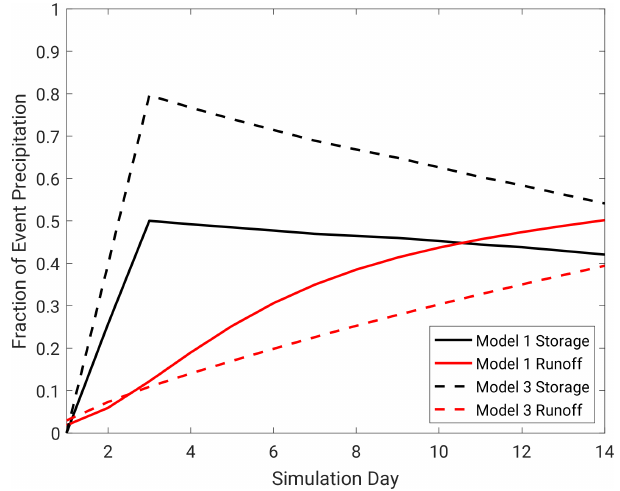
Figure 14. Change in storage (black lines) and cumulative runoff (red lines) normalized by flood event precipitation input for model 1 (solid) and model 3 (dashed) at Island Park for one precipitation frequency distribution bin, using the median (50th percentile) pre- cipitation frequency